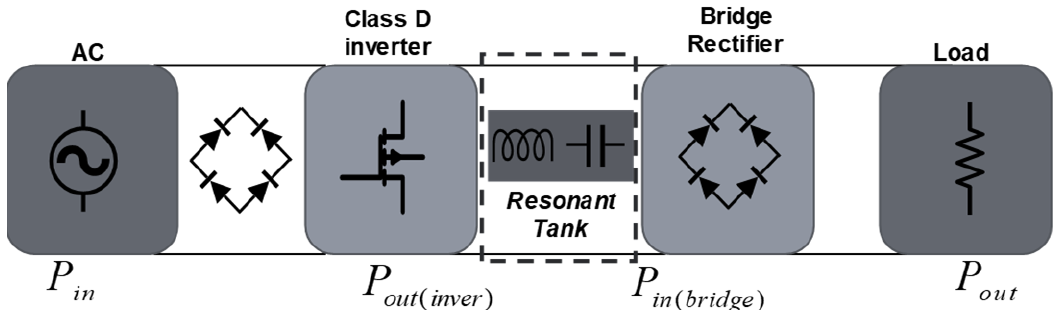
Figure 22. Block diagram of the circuit.